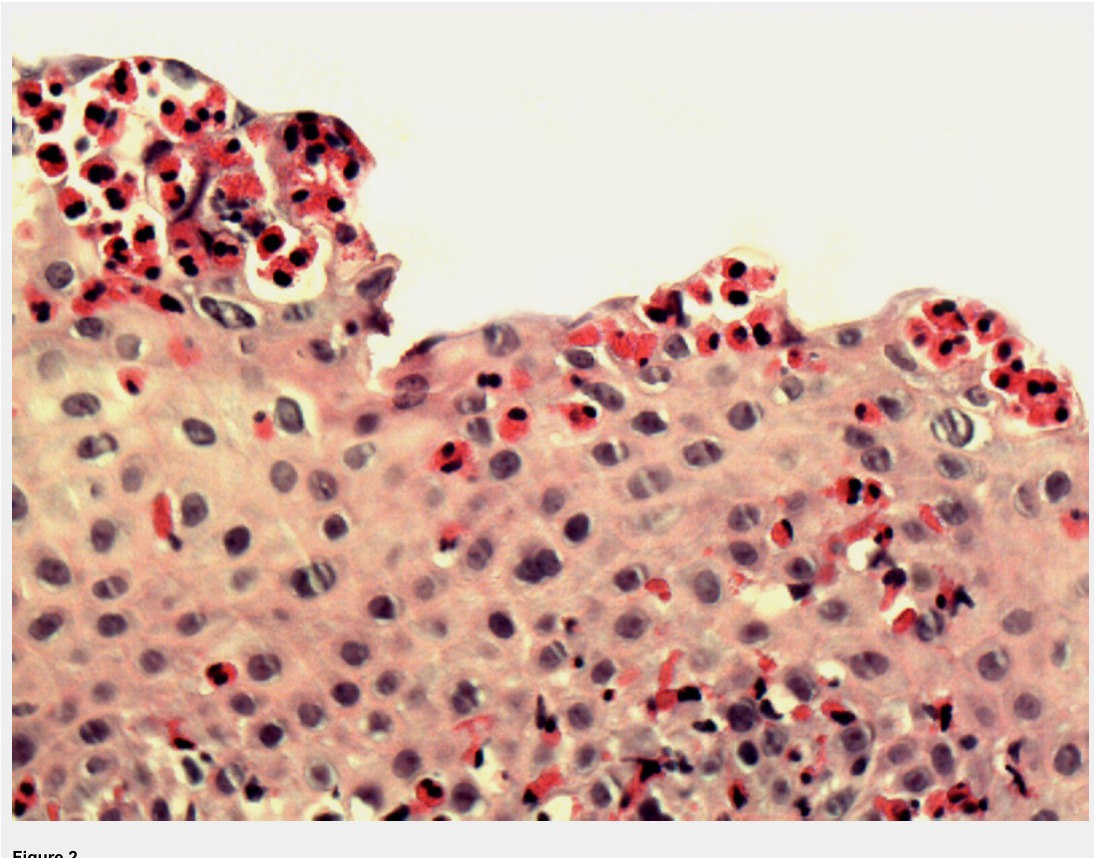
Figure 2 Biopsy specimen illustrating the leading histopathologic signs of EoE: The histograph, taken from an adult patient with active EoE, shows a dense infiltration of the squamous esophageal epithelium with eosinophils and dilated intercellular spaces. H&E staining, original magnification